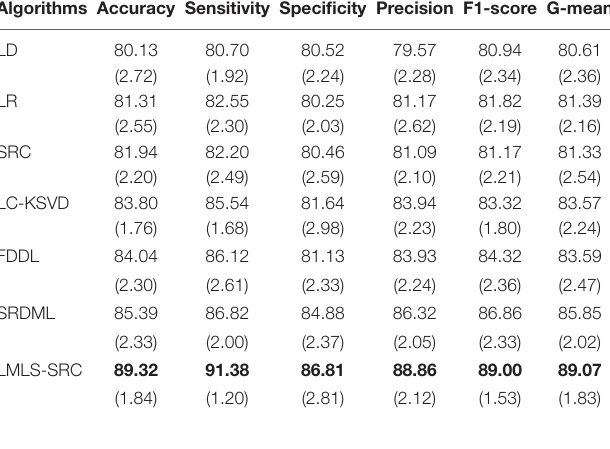
TABLE 3 | The comparative training results (with standard deviation) in three-class classification task.